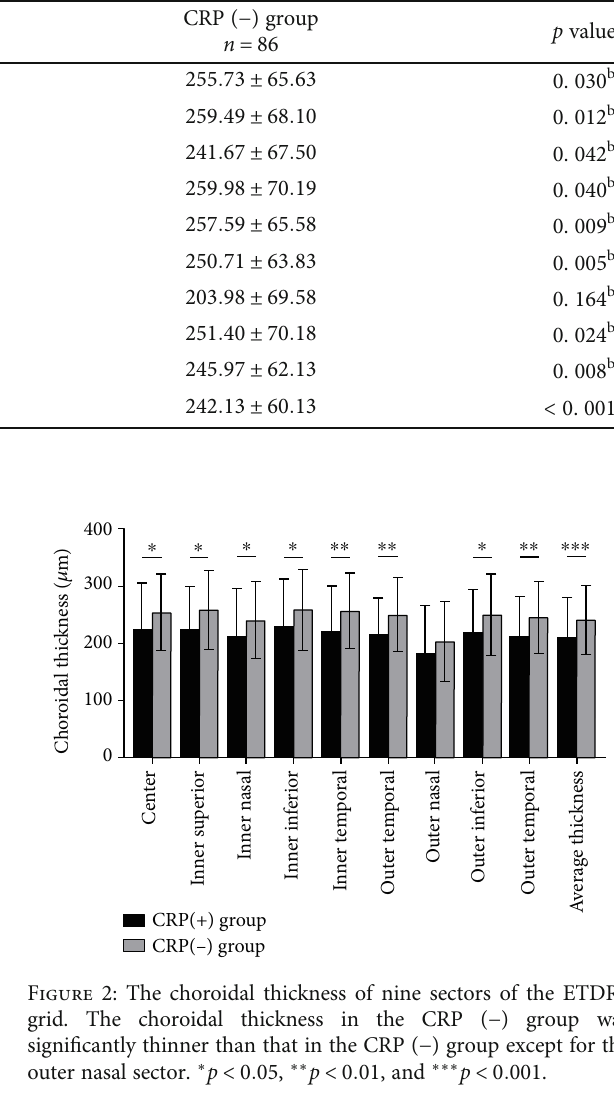
Figure 1. The mean retinal thickness was 276 : 66 ± 18 : 87 μ m in the CRP (+) group and 277 : 87 ± 11 : 86 μ m in the CRP ( − ) group. The retinal thickness in the CRP (+) group was